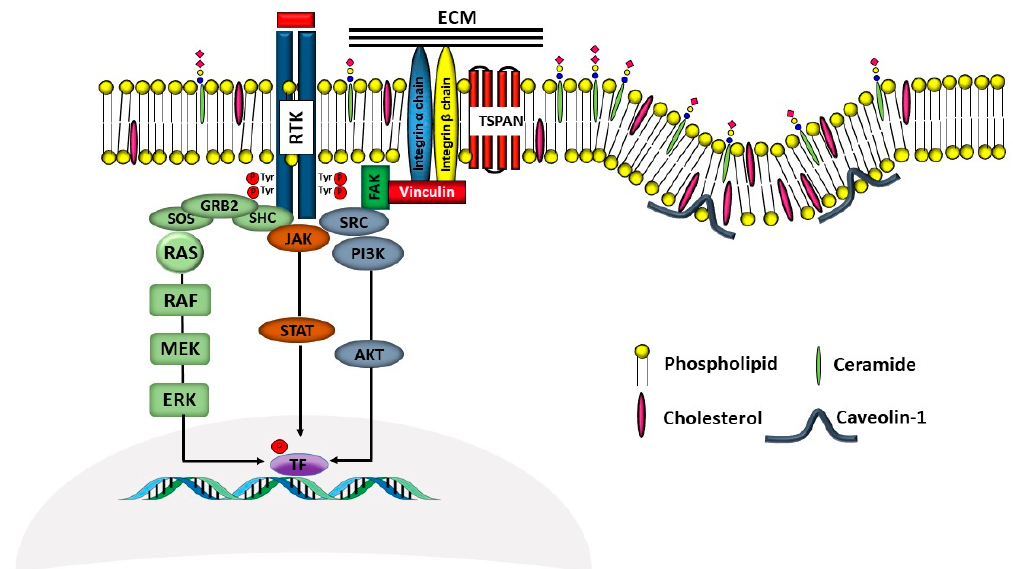
Figure 2. Schematic representation of membrane microdomains. The complex interactions among RTKs, integrins and tetraspanins with signal transduction molecules leading to gene transcription, are depicted in a simplified representation. The left part of the Figure represents a tetraspanin microdomain, while the right part represents a caveola with caveolin-1. Sugar codes are as in the legend of Table 1.